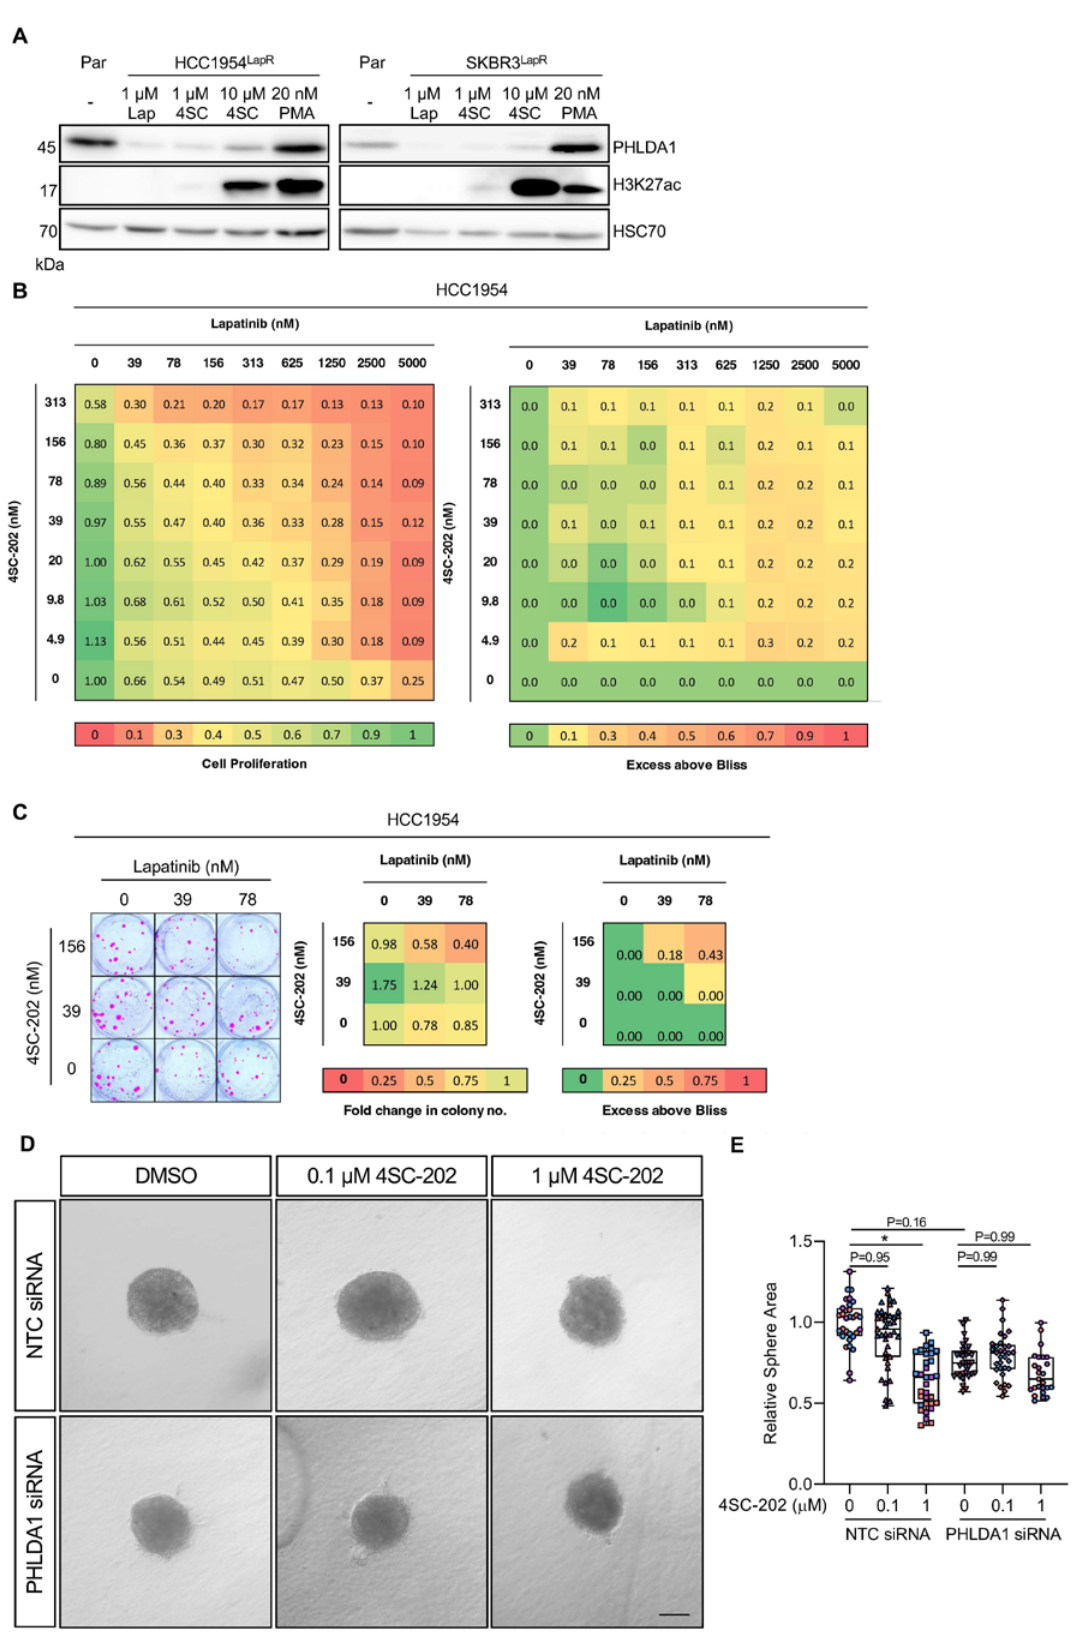
Figure 4. HDAC inhibitor 4SC-202 restores PHLDA1 expression in lapatinib-resistant cells and acts synergistically with lapatinib to inhibit cell proliferation. ( A ) Western blot analysis of PHLDA1